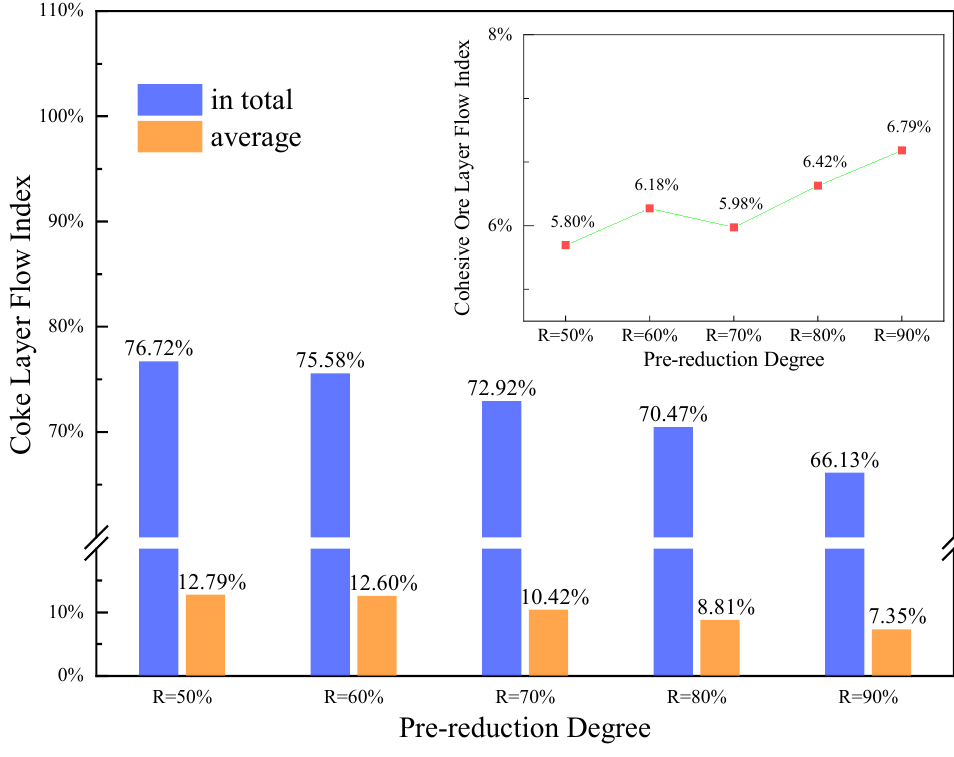
Figure 11. Flow index of the CL and the COL.